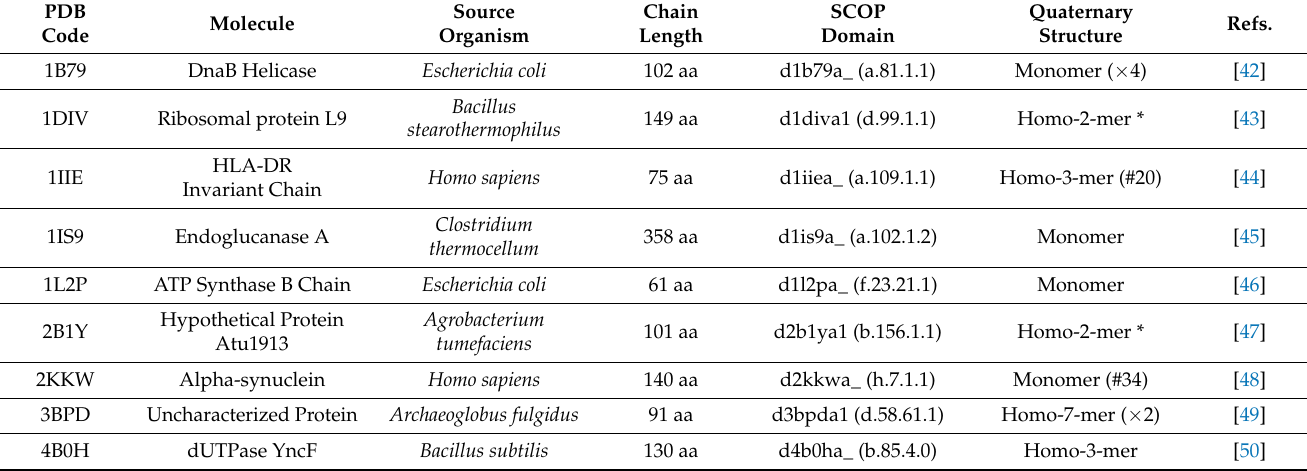
Table 1. Proteins used as examples. Data in Quaternary Structure column denotes composition of author-assigned biomolecule containing the domain shown in SCOP Domain column. Asterisk (*) marks complexes recreated with symmetry operators obtained from REMARK 350 records of the PDB header. Values after hash (#) correspond to number of solution NMR models present in the PDB